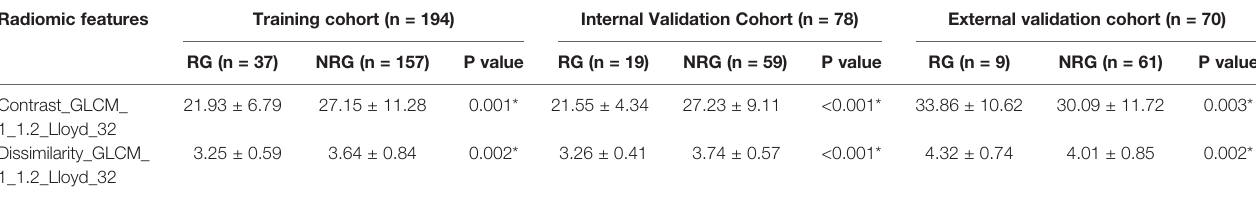
TABLE 2 | Radiomic features of the RG and the NRG in the training and validation cohorts. Radiomic